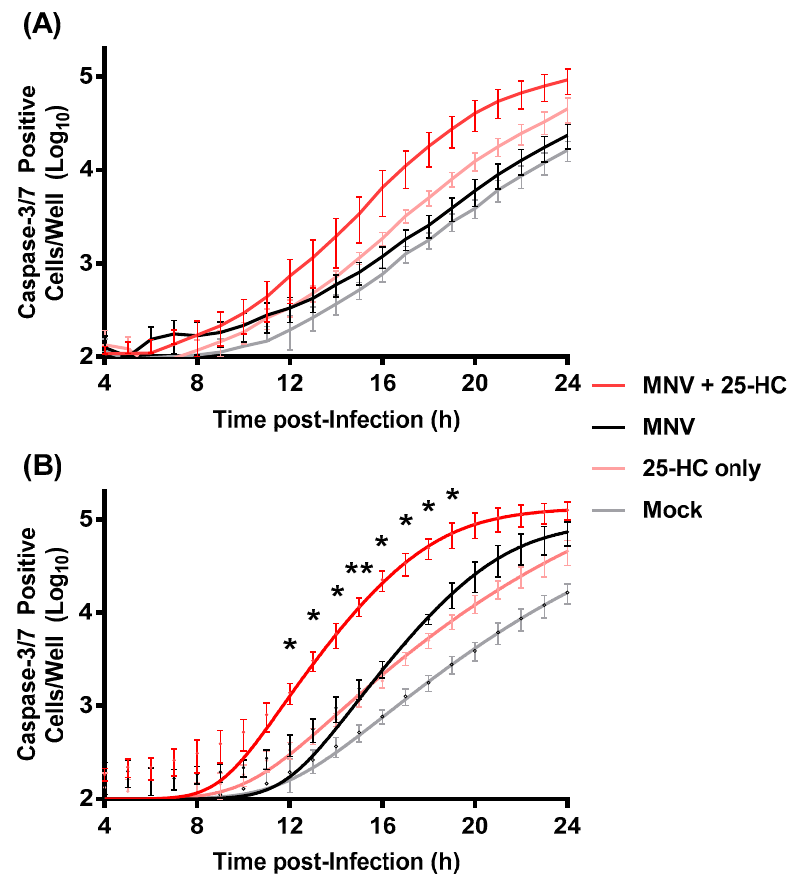
Figure 4. MNV-induced apoptosis in the presence of 25-HC. Replicate wells of RAW264.7 cells were infected with MNV at an MOI of ( A ) 0.05 or ( B ) 5 TCID 50 /cell and immediately treated with 25-HC (6.6 µ M). As controls, the replicate wells were infected with MNV without the addition of 25-HC or treated with 25-HC alone. To quantify apoptosis, the caspase 3/7 assay reagent was added directly to the wells immediately after infection and the caspase activity was measured by fluorescence at regular intervals using IncuCyte ZOOM FLR. Data are shown as mean caspase-3/7 positive cells per well and statistical analysis of MNV with 25-HC by comparison to the MNV-only sample ( n = 4 ± SEM, * = p < 0.05, ** = p < 0.01).